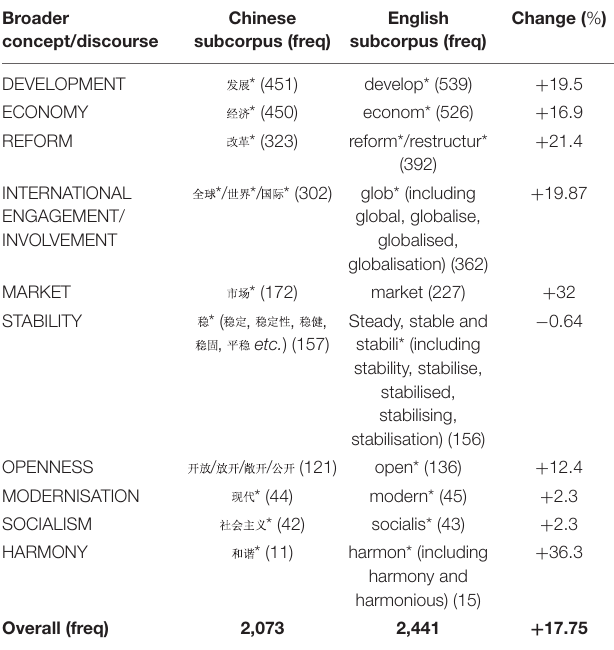
TABLE 2 | Instances of lexical items relating to ROU in Chinese and English